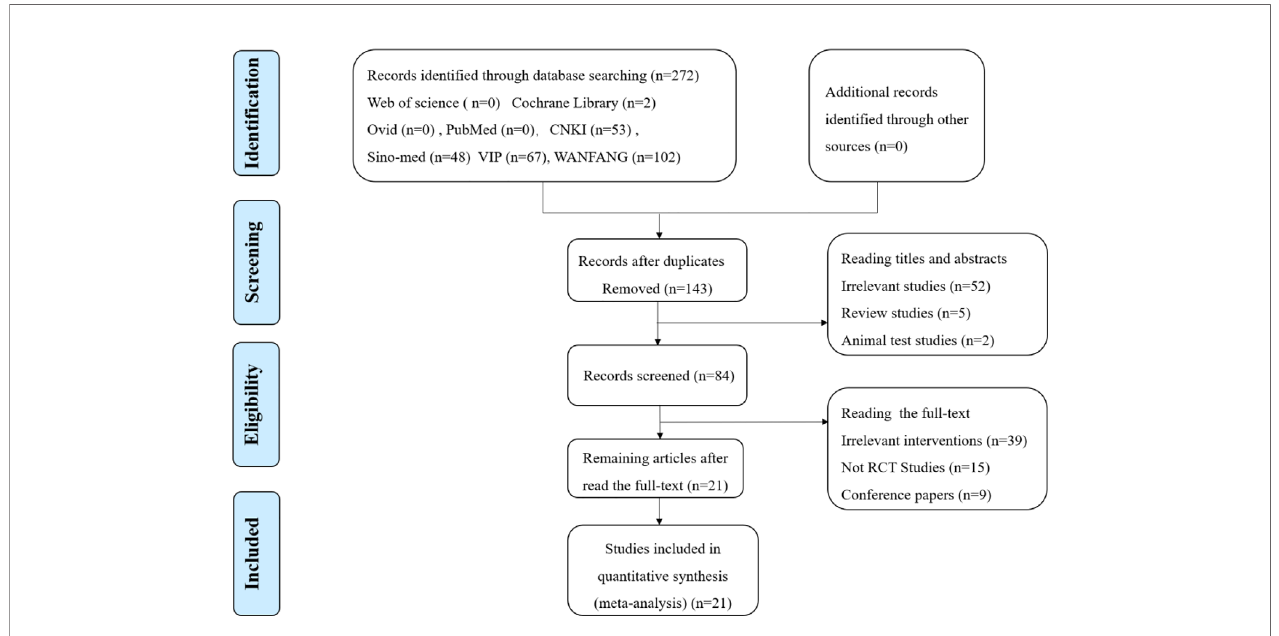
FIGURE 1 | Flow chart of study